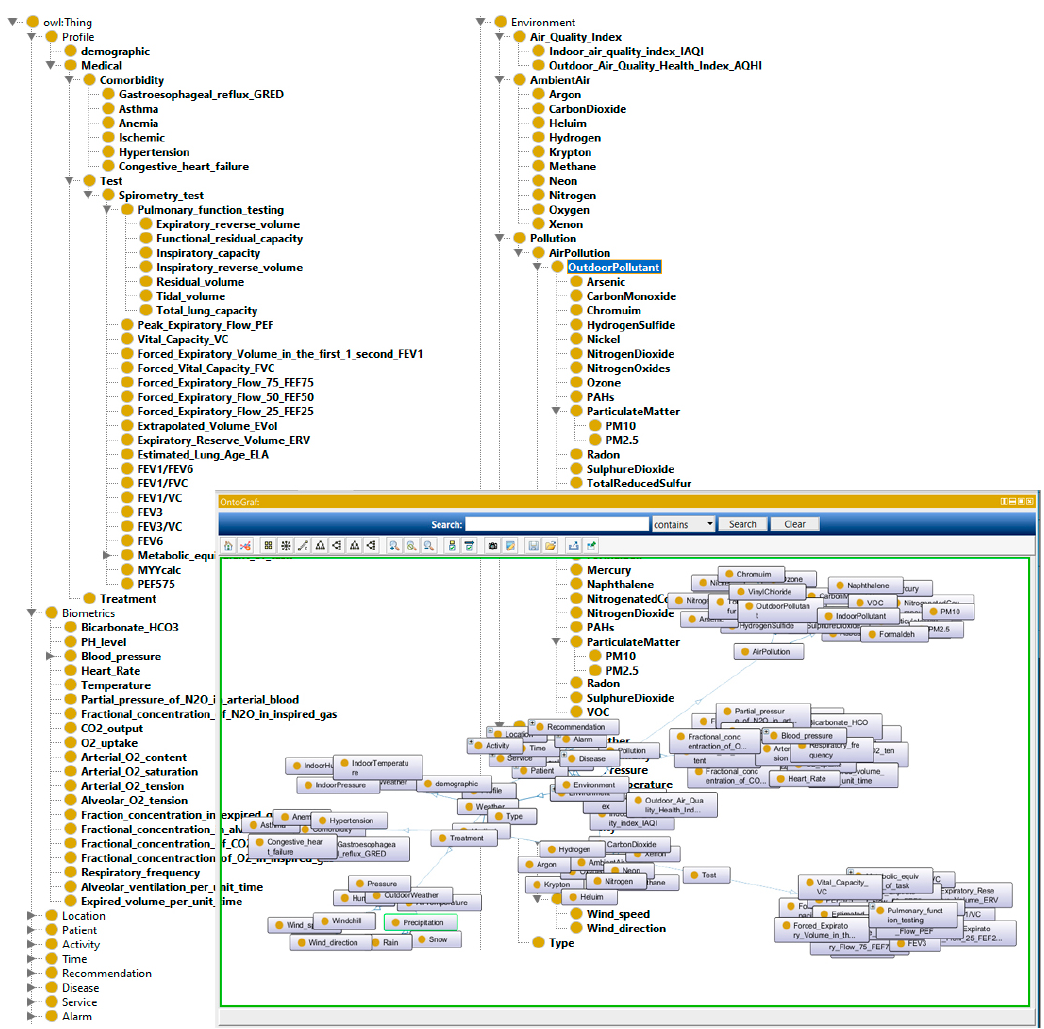
Figure 13. Portion of the proposed ontology.